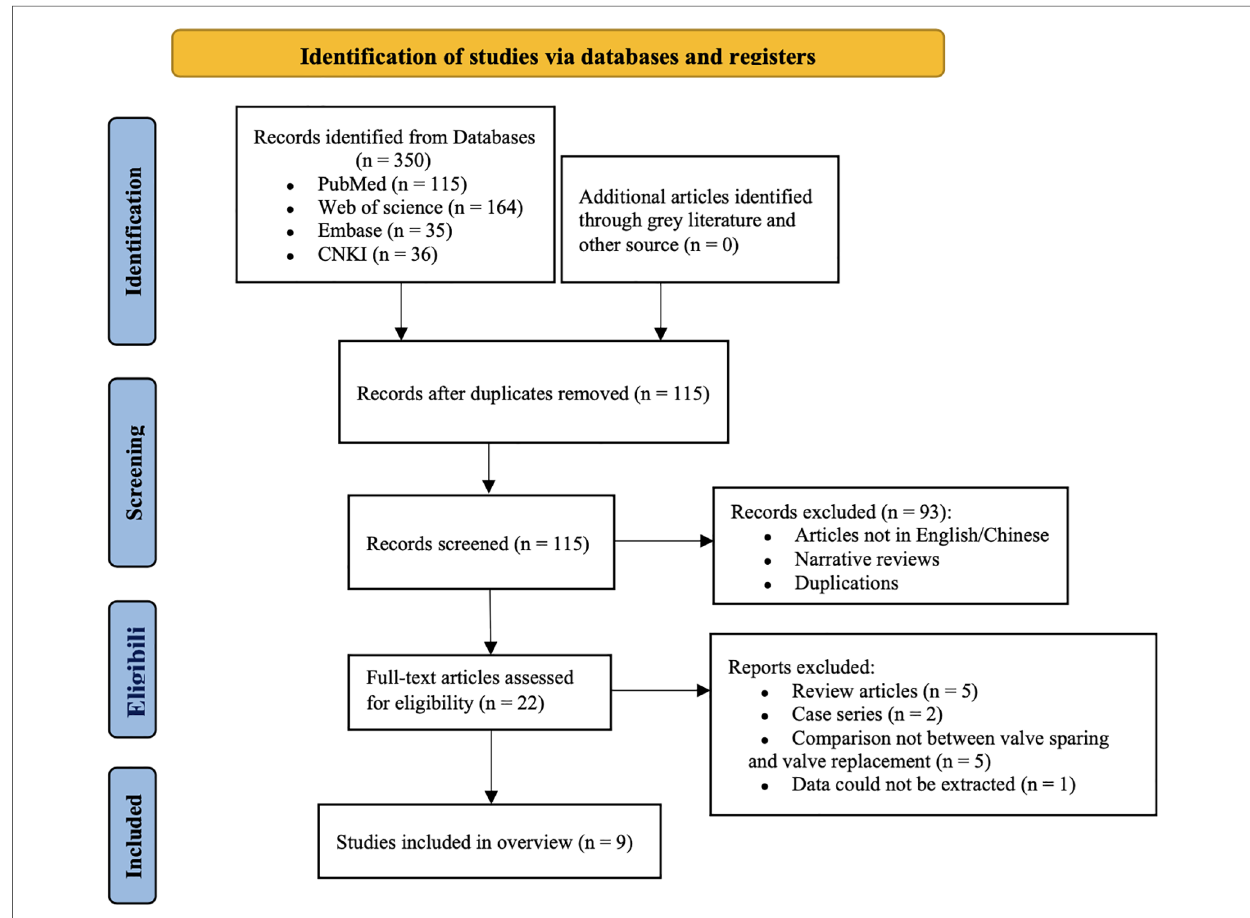
FIGURE 1 Flow diagram of the search and screening of the literature included in this